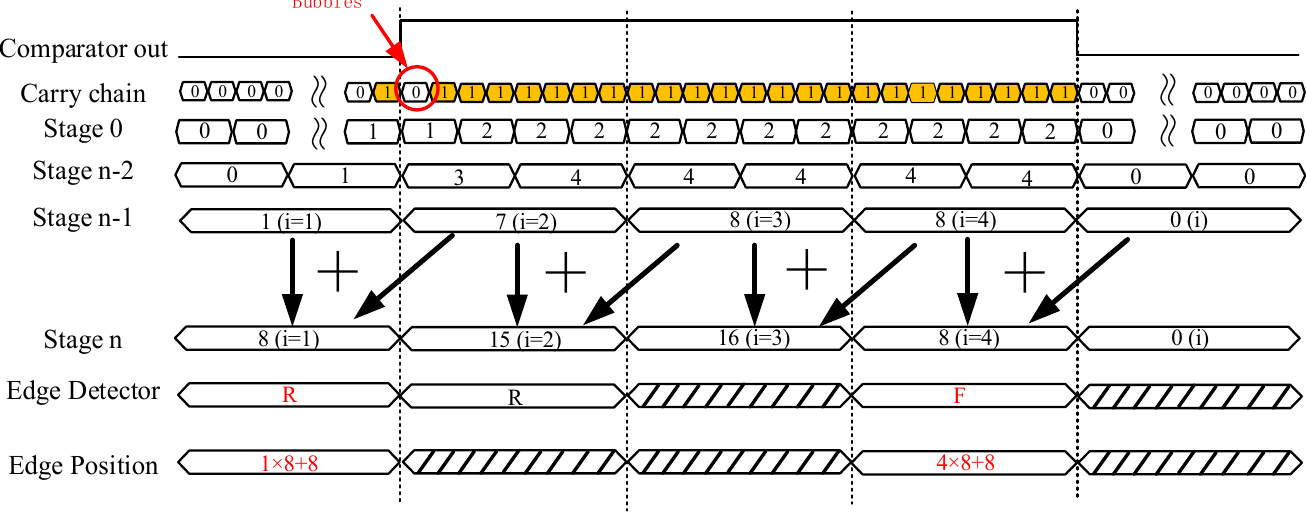
Figure 4. Timing diagram of the edge detector and bubble filtering. “Reproduced from [20]”. Once all sums are calculated, the rising edge and falling edge are detected by Algorithms 1. When the first rising edge and falling edge are determined, the number i